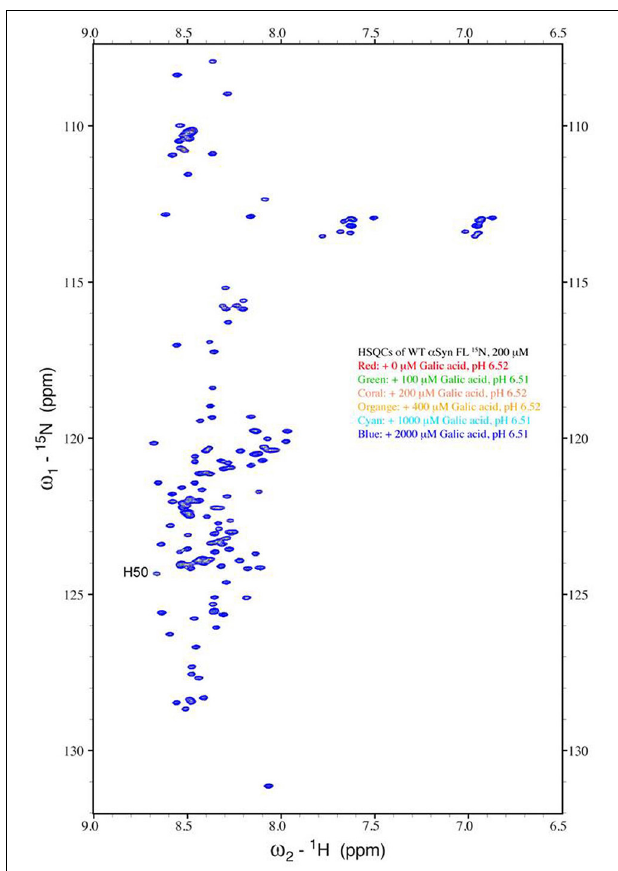
FIGURE 7 | Analysis of GA binding to monomeric α -syn by NMR spectroscopy. Proton-Nitrogen correlation (HSQC) spectra of monomeric α -syn in the presence of increasing ratios of GA: α -syn demonstrating that there are no significant changes in the positions of the NMR resonances, indicating the lack of an interaction between GA and monomeric α -syn. Protein concentration was ca. 200 μ